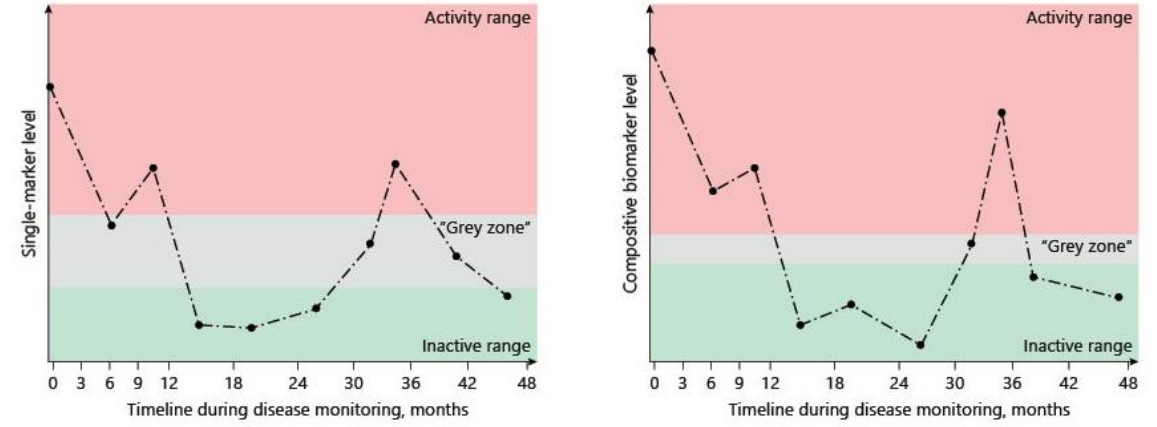
Figure 2. Improvements are provided by composite biomarkers. Careful selection of markers and their integration can optimize the diagnostic accuracy of single biomarkers of disease activity and drastically reduce the blind spot resulting from the “grey zone”. Adapted from Dragoni G. et al.’s review [55]; Digestive Diseases ,